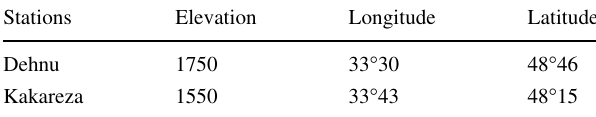
Table 1 Hydrometric stations